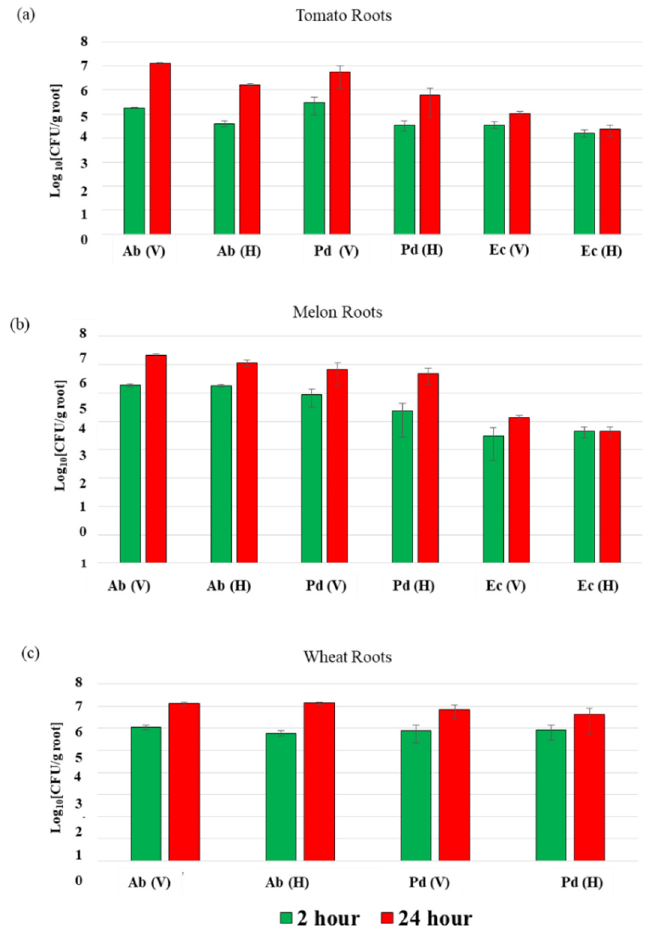
Figure 1. Root colonization ability of Azospirillum brasilense Sp7 (Ab) and Paenibacillus dendritiformis T (Pd) on roots of tomato cv. M82 ( a ), melon cv. Ofir ( b ), and wheat cv. Bar Nir ( c ). Seven-day-old roots were incubated for 2 or 24 h in bacterial suspensions with 10 8 CFU mL − 1 . After gentle washing of the roots, bacteria were detached from the roots by vortex (V), followed by homogenization (H), and CFU g − 1 root were determined by dilution plating following each one of the treatments. Data represent means and standard errors (SE) of four replicates per treatment of one experiment, out of four with similar results.